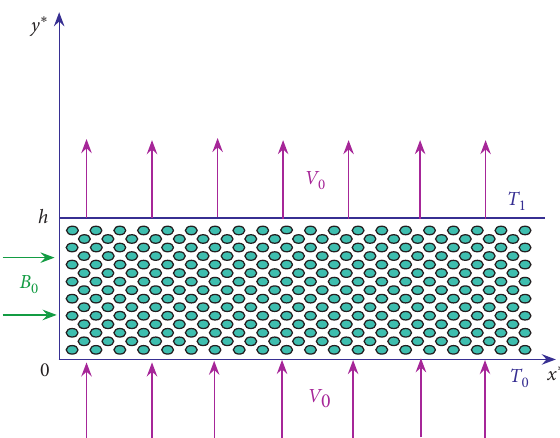
Figure 1: Physical model and the coordinate